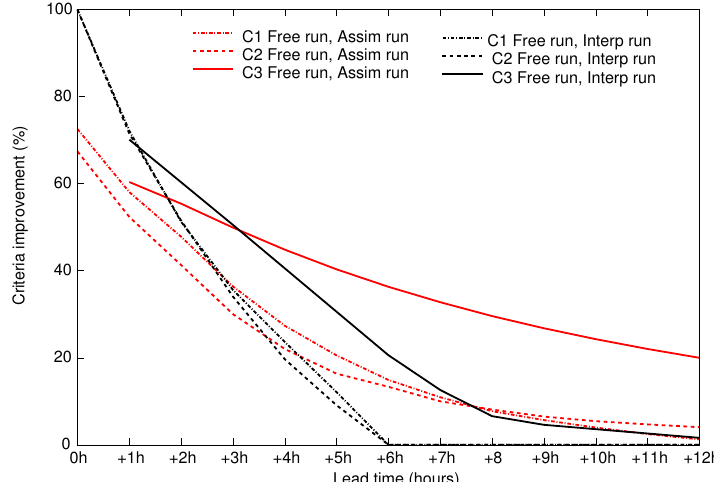
Fig. 13. Improvement in C1 (dashed-dotted),C2 (dashed) and C3 (solid) (in %) between Assim run and Free run (red curves) and between Interp run and Free run (black curves). Average of seven flood events, at Peyrehorade (Adour).